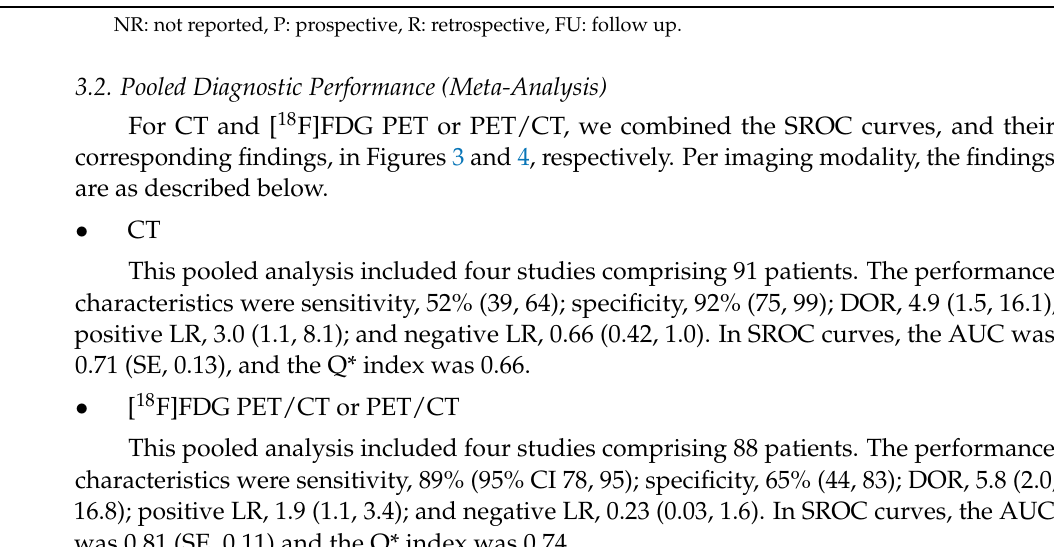
Figure 2. Quality assessment of the included studies using Quality Assessment of Diagnostic Accuracy Studies 2 (QUADAS-2).